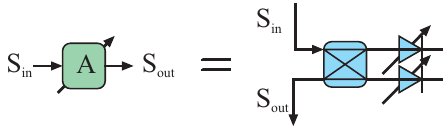
Figure 4. Symbol and schematic of a reflection-type variable attenuator.